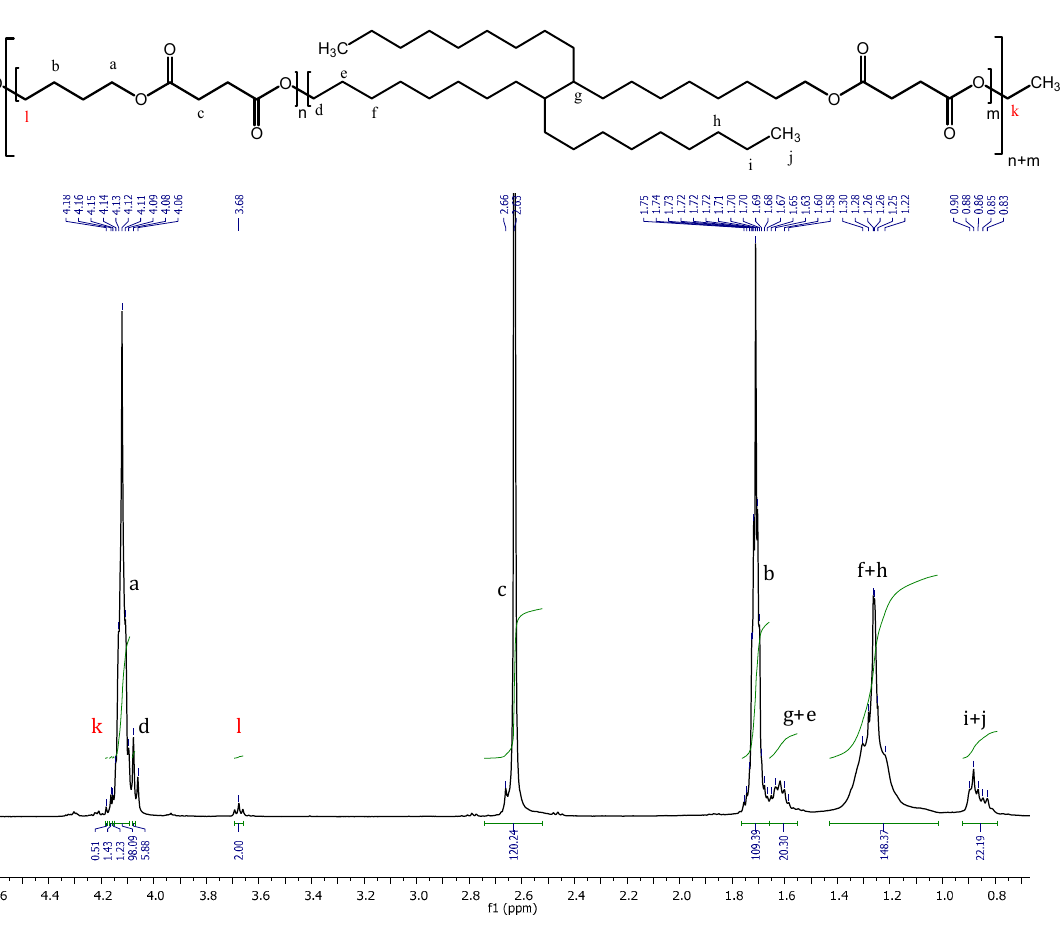
Figure 2. 1 H NMR of poly(butylene succinate- co -dilinoleic succinate) 70:30 copolyester.